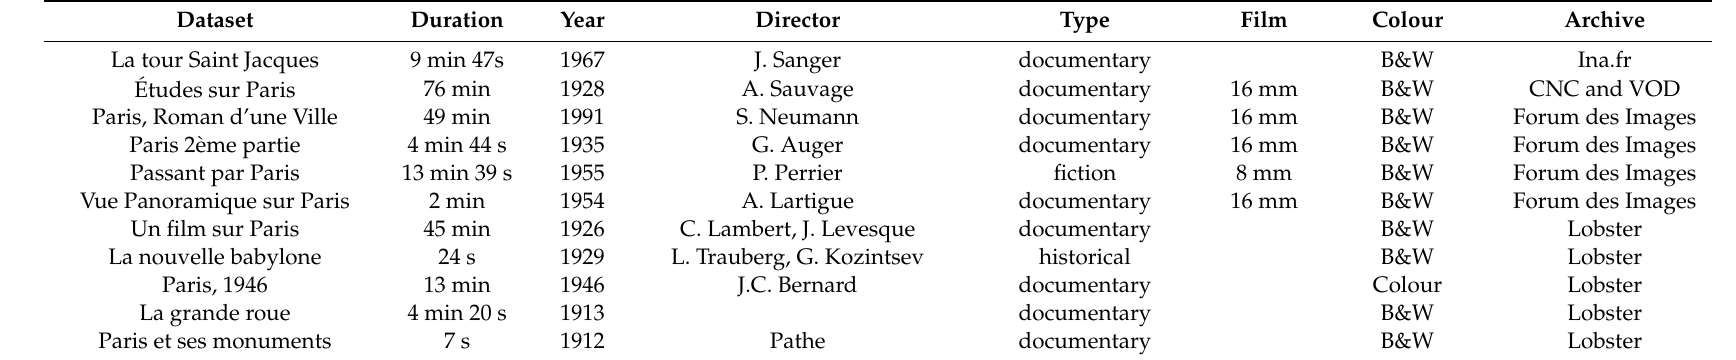
Table 2. Description of the video dataset of the Tour Saint Jacques.